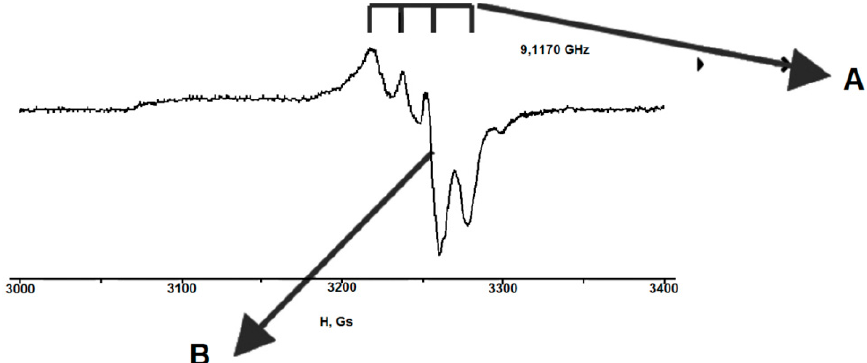
Figure 5. ESR spectra of a Cu—4-cyano-4 ′ -pentylbiphenyl co-condensate film at 77 K (Y-axis is the intensity of ESR-signal in related unites).